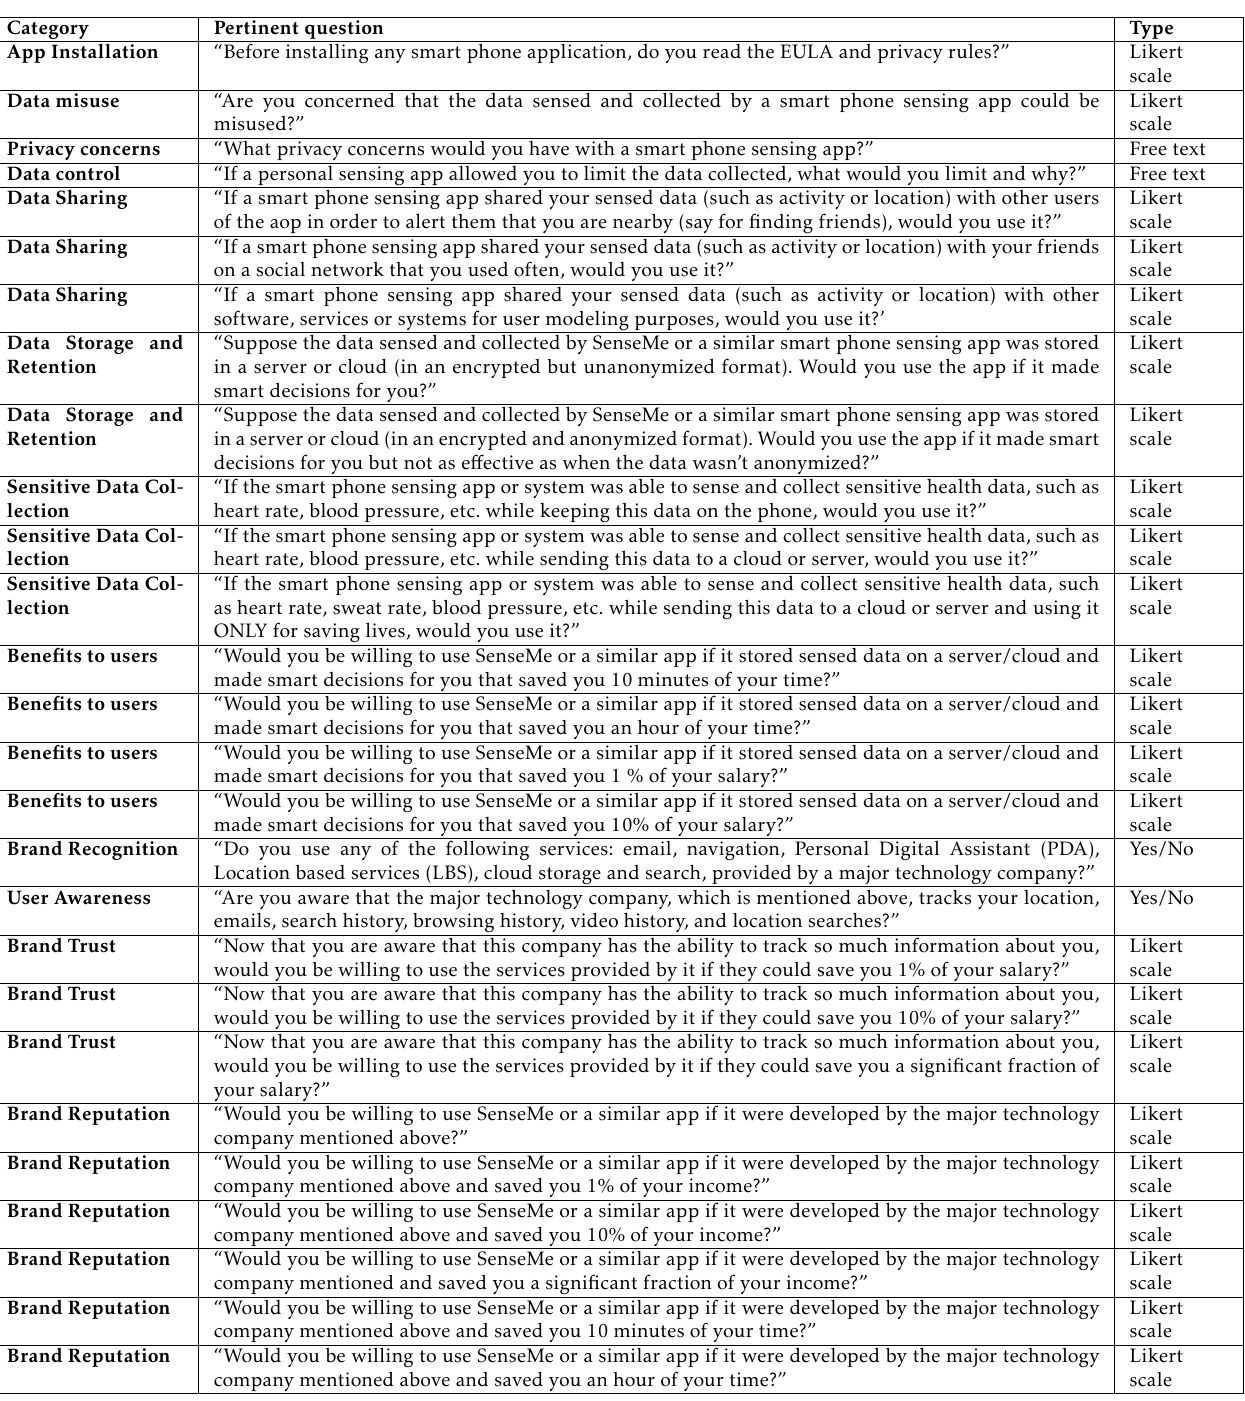
Table 1. Privacy and trust related questions from our study